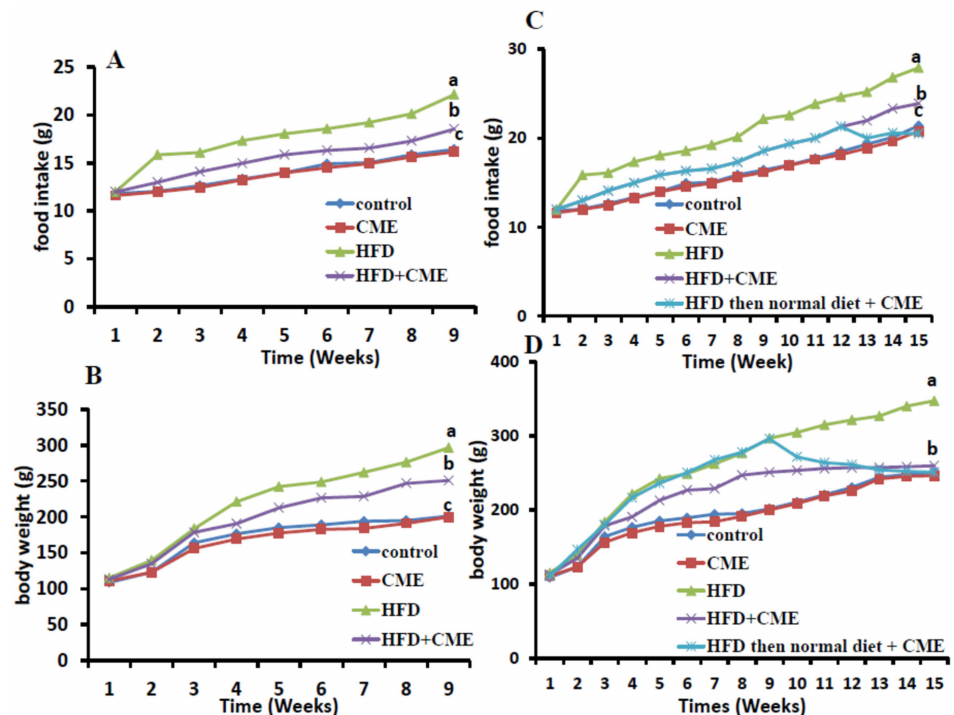
Figure 2. E ff ect of high fat diet (HFD) and / or Commiphora myrrha resin extract (CME) on food intake and body weights. Rats were fed either basal (normal control group) diet; basal diet and administered CME (500 mg / kg bw) for 14 weeks; HFD; HFD and administered CME (500 mg / kg bw) for 14 weeks or HFD for 8 weeks then basal diet and administered CME (500 mg / kg bw) for another 6 weeks. Daily food intake after 8 weeks ( A ) and after 14 weeks ( C ) and weekly live body weight of rats after 8 weeks ( B ) and after 14 weeks of the experiment ( D ) were recorded. Values presented are the mean ± SE. Di ff erent letters means significant di ff erence ( p < 0.05) from the other groups.